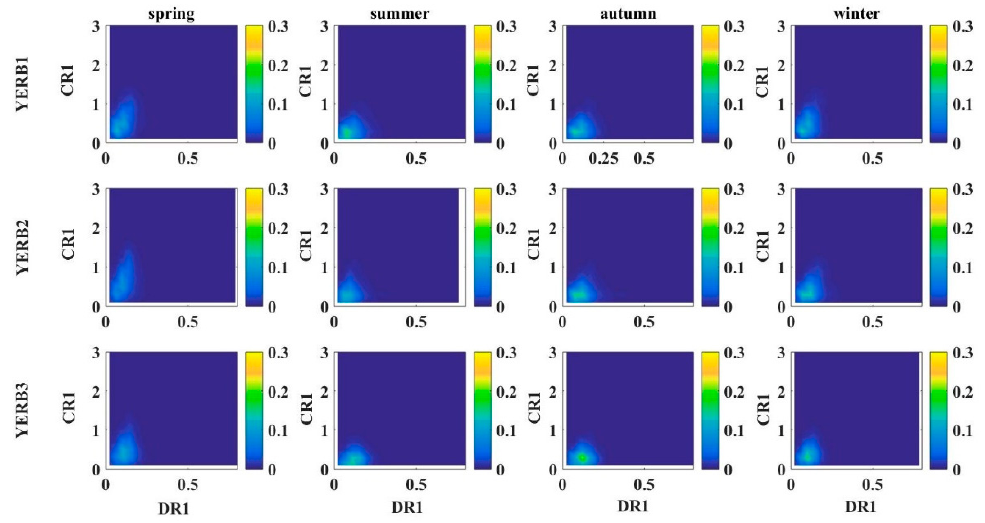
Figure 9. Probability distribution diagram of correlations between DR 1 and CR 1 over YERB.